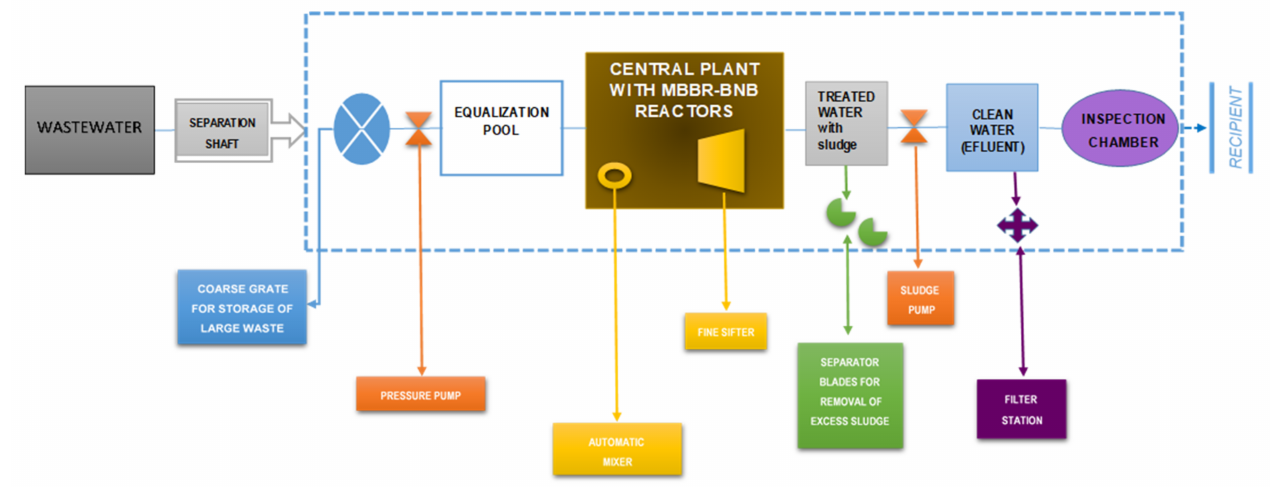
Figure 1. Process Flow Diagram of Variant V3.